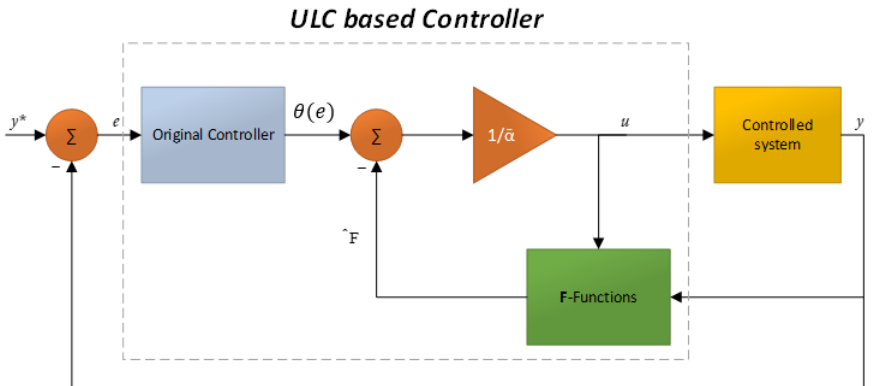
Figure 3. Ultra-local based controller structure.